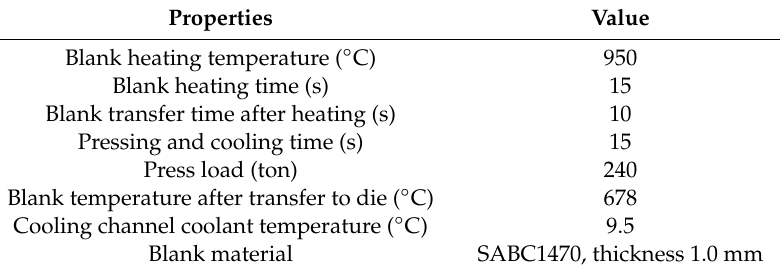
Table 11. Main stamping process